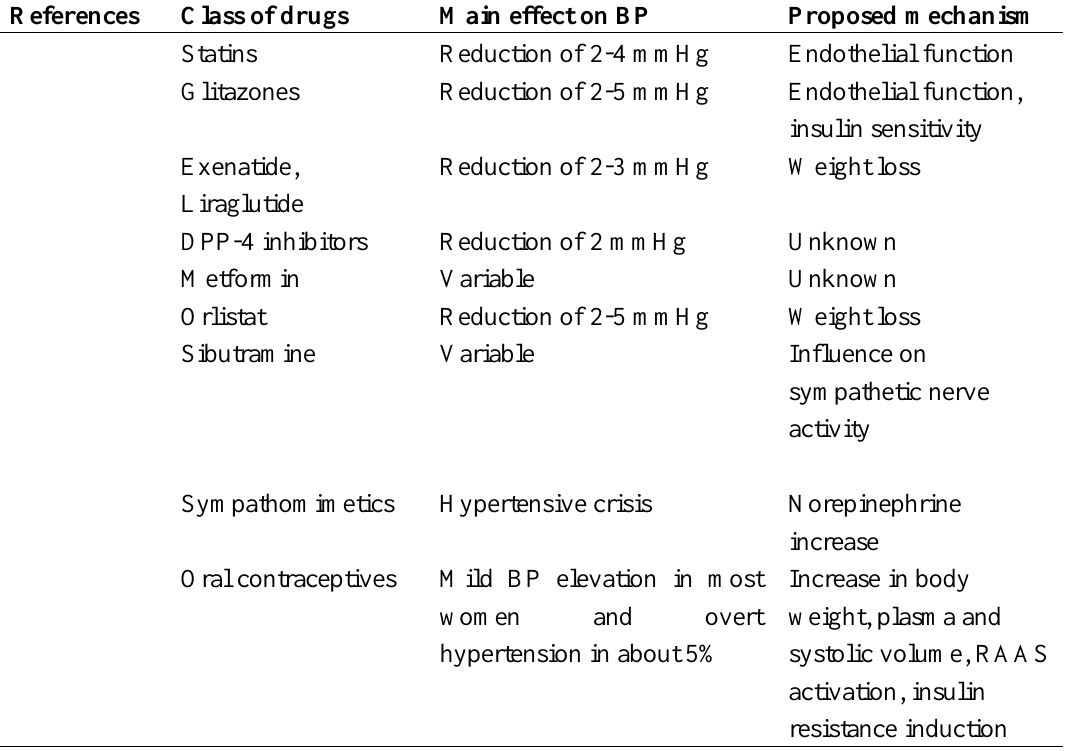
Table 1. A summary of drug-induced effects on blood pressure levels, based on individual studies and systematic